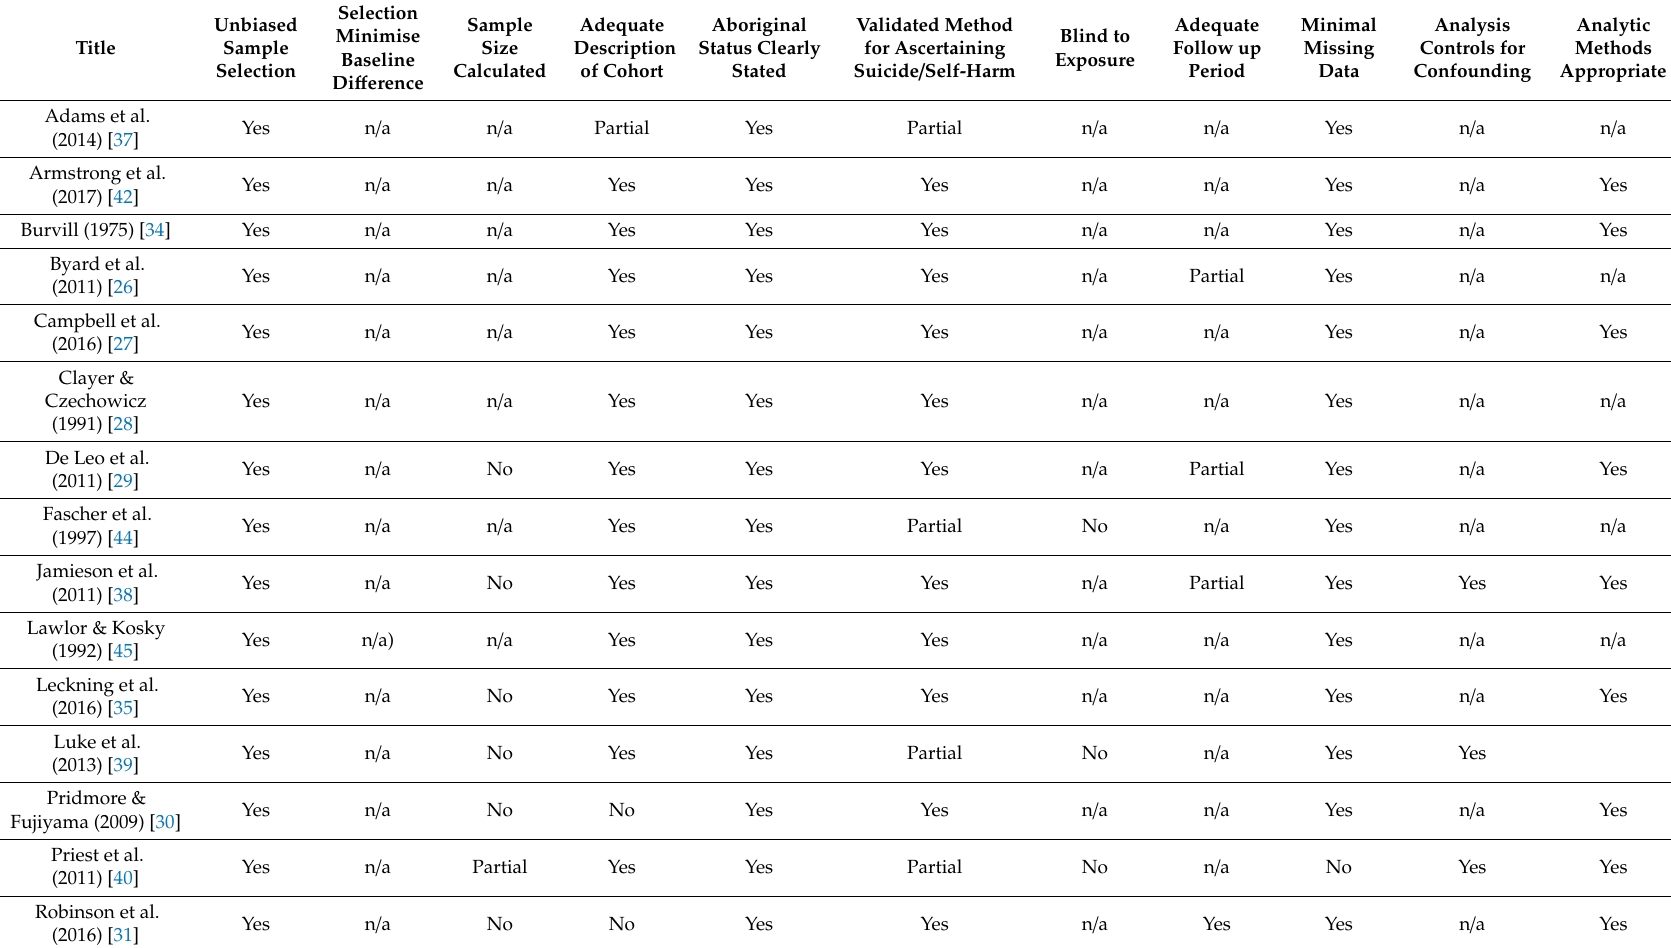
Table 1. Quality